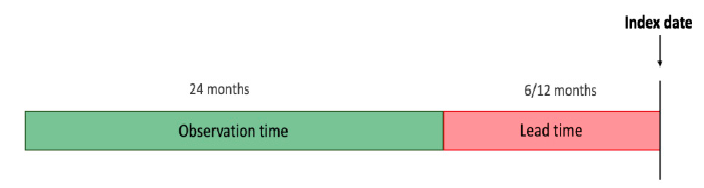
Figure 1. Chronology of time periods and events.